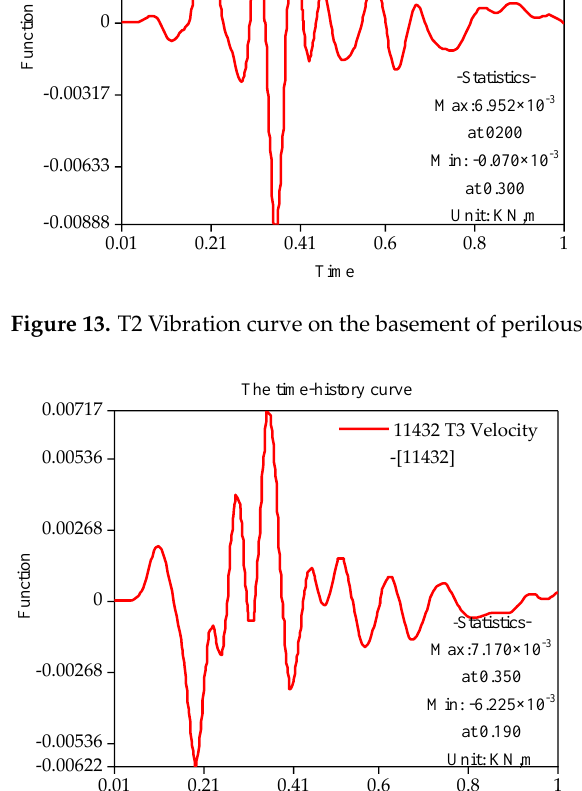
Figure 15. The vibration velocities of retaining walls at 50 ms.